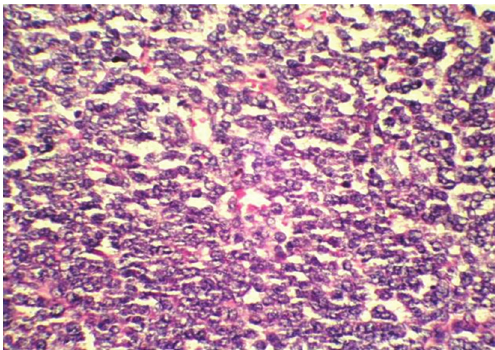
Figure 4: Histopathlogical examination of the biopsy in Case 2 showing sheets of small round blue cells ( × 400